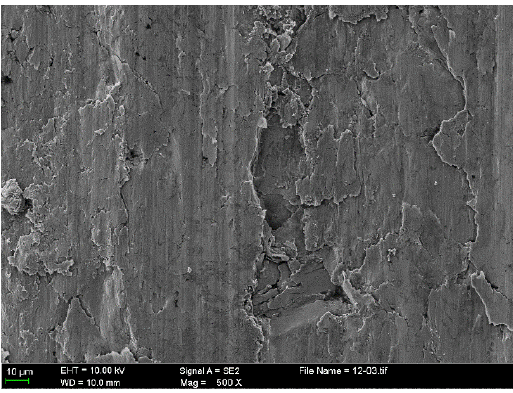
Figure 10. Enlarged worn surface of severely damaged region from the scuffed liner of CKS/Fe. Materials 2017 , 10 , 1176